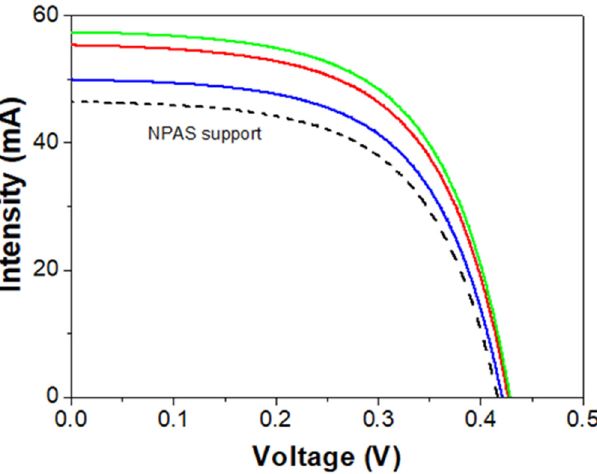
Figure 8. Intensity-voltage curves for the BMIMPF 6 /NPAS (solid red line), the OMIMPF 6 /NPAS (solid green line), and the EMIMBF 4 /NPAS (solid blue line) systems and the NPAS support (dashed black line). Table 6. Average values of short circuit current (I sc ) and power at the maximum power point (P mp ) determined for the three IL/NPAS systems.